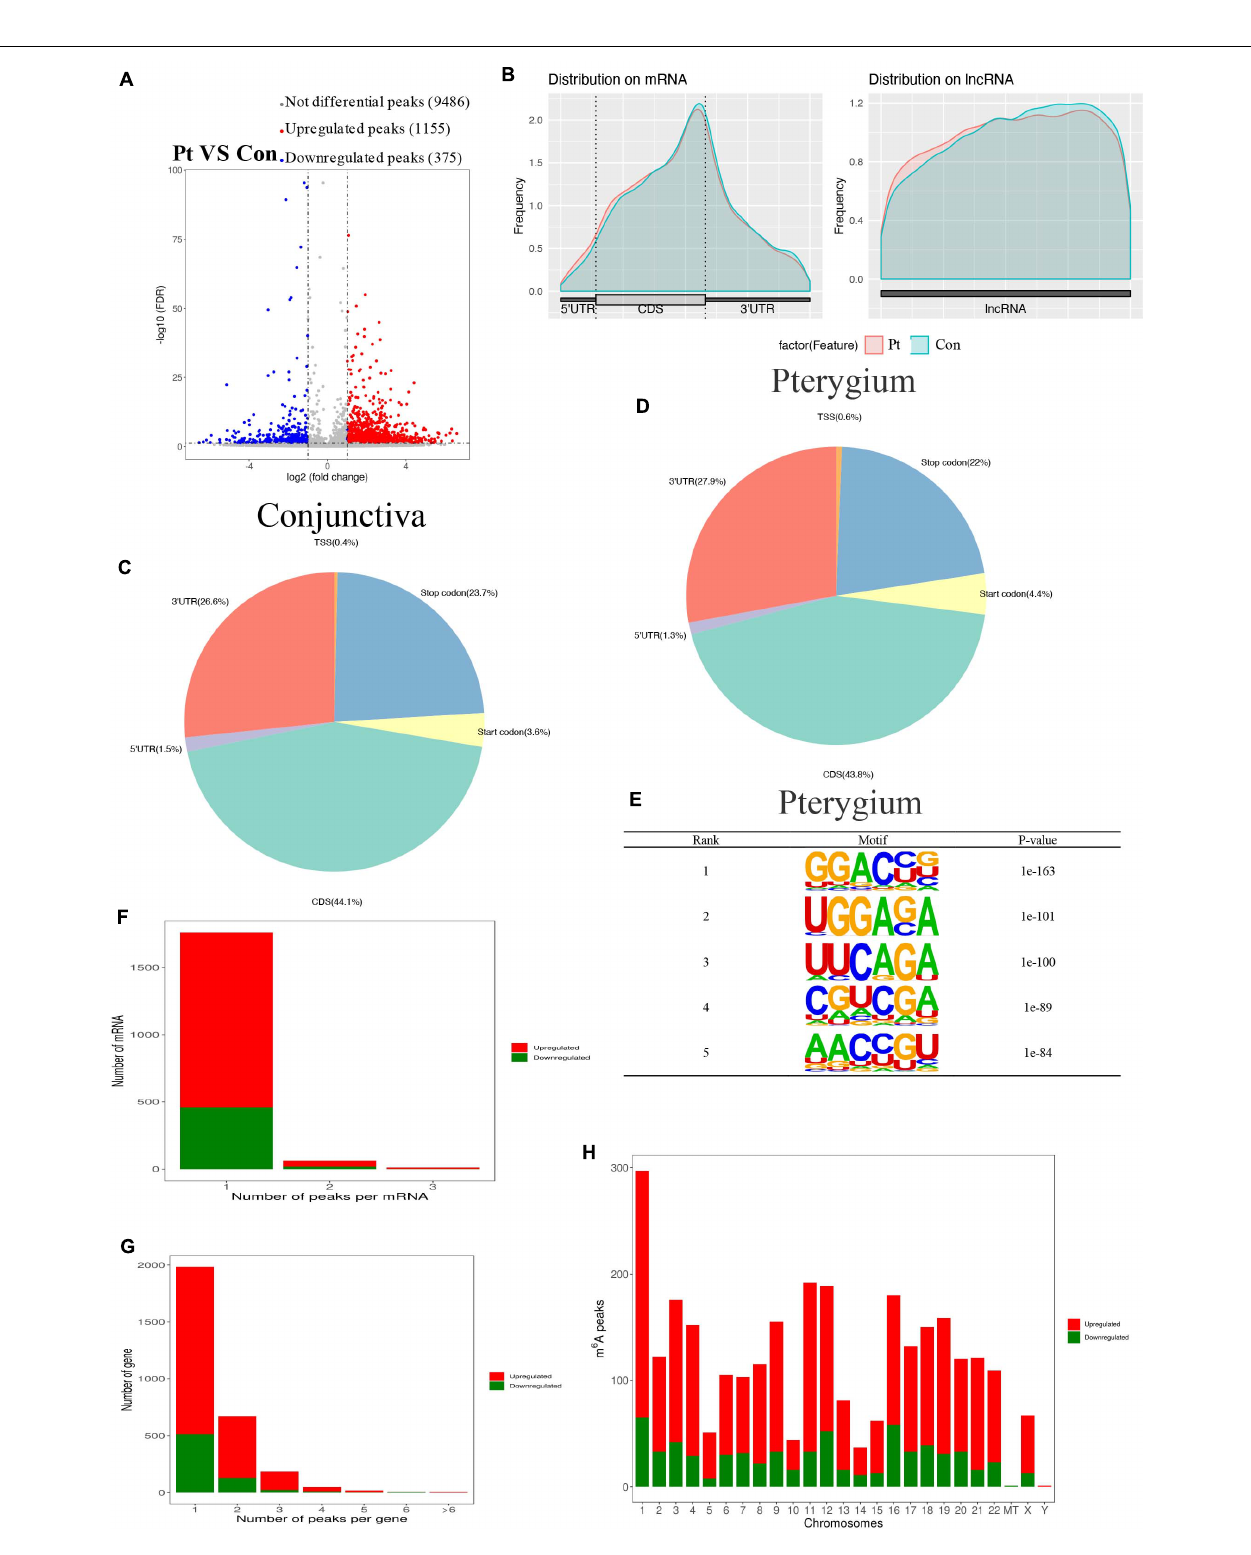
FIGURE 3 | Overview of altered m6A-modified transcripts in pterygium. (A) Volcano plots showing significantly different m6A peaks. (B) Average m6A peaks in conjunctiva and pterygium. (C,D) Pie charts showing the distribution of m6A peaks in conjunctiva (C) and pterygium (D) . (E) Top five m6A motifs from the altered m6A peaks in pterygium. (F) Distribution of altered m6A peaks per mRNA. (G) Distribution of altered m6A peaks per gene. (H) Distribution of altered m6A peaks in human chromosomes. Fold change ≥ 2 and P < 0.05.